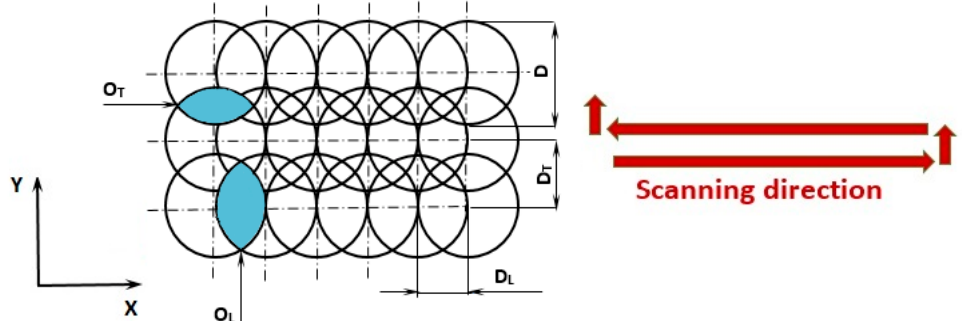
Figure 3. Schematic representation of the laser beam tracks. D—spot diameter, D L —lateral overlap distance, D T —transverse overlap distance, O L —lateral overlap, O T —transverse overlap.